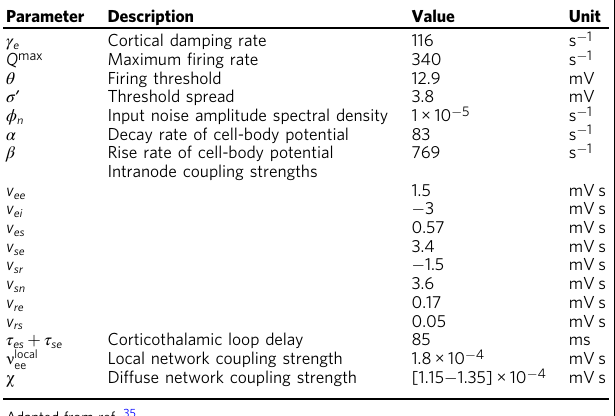
Table 1 Corticothalamic neural mass